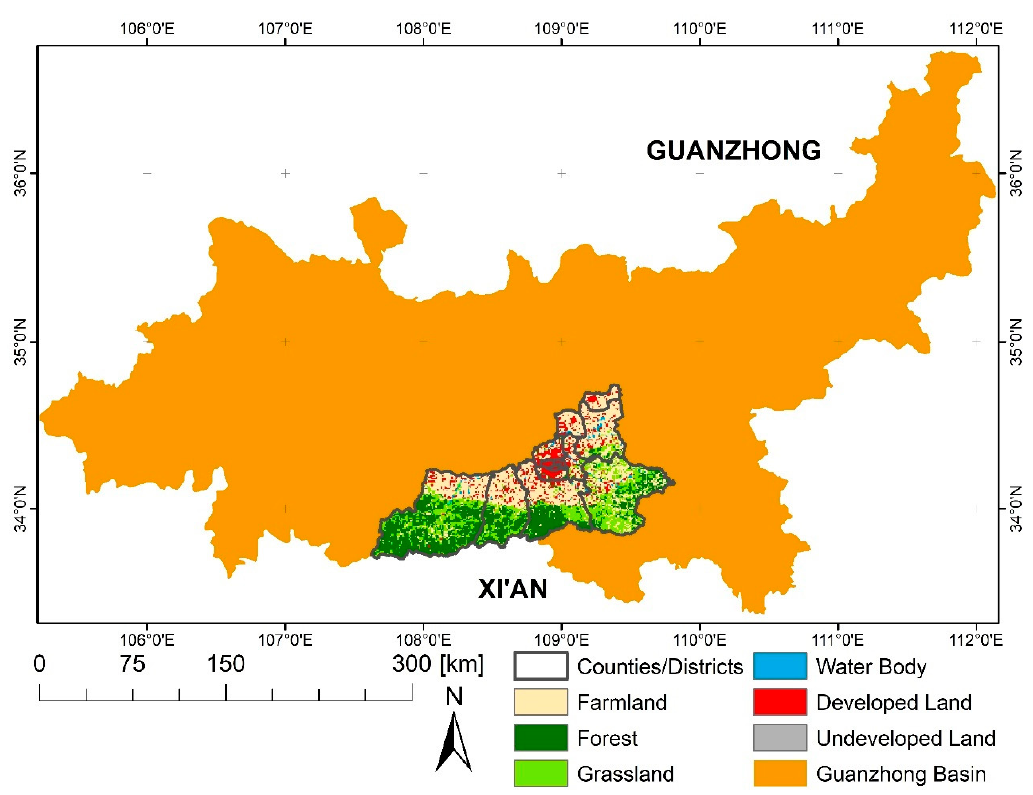
Figure 1. The study area covers the city of Xi’an in northwest China.